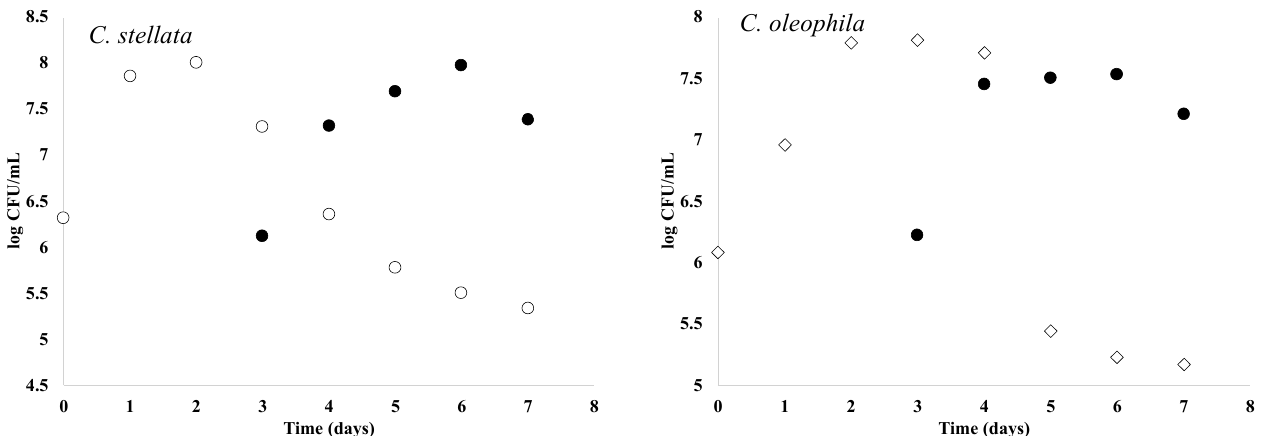
Table 6. Sugar utilization and ethanol production observed during the sequential fermentation of C. stellata and C. oleophila with S. cerevisiae .